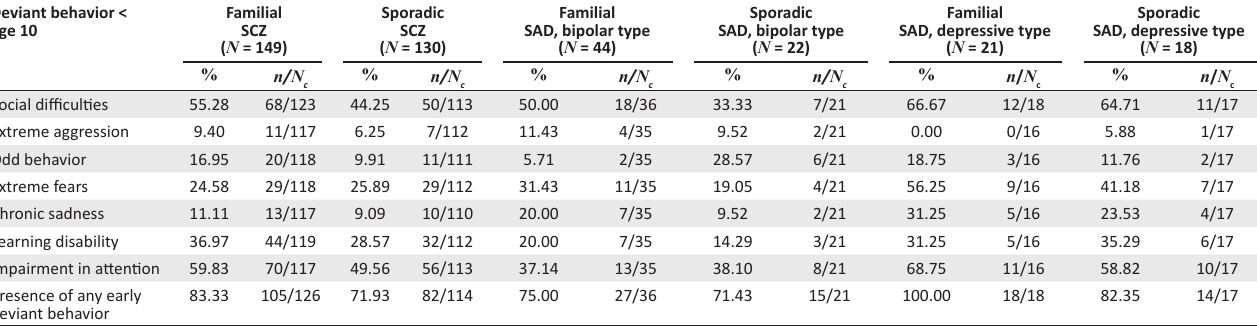
TABLE 1e: Demographic & clinical characteristics of 214 familial and 170 sporadic participants with a DSM diagnosis of schizophrenia or schizoaffective disorder. Deviant behavior < age